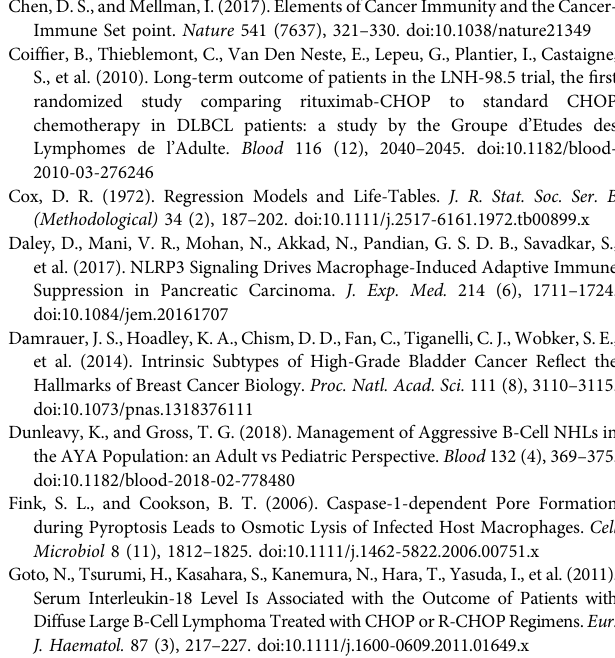
Supplementary Figure 2 | (A – D) Results of internal veri fi cation of the seven-gene signature, using the bootstrapping method. (E,F) ALasso analysis ofthe prognostic PRGs in